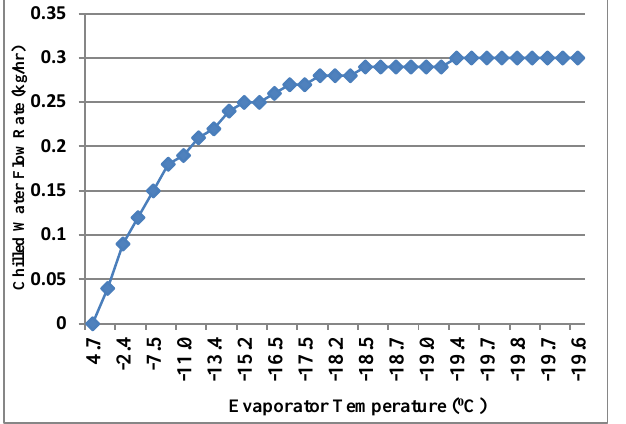
Figure 9: Experimental chilled water flow rate at 5 ℃